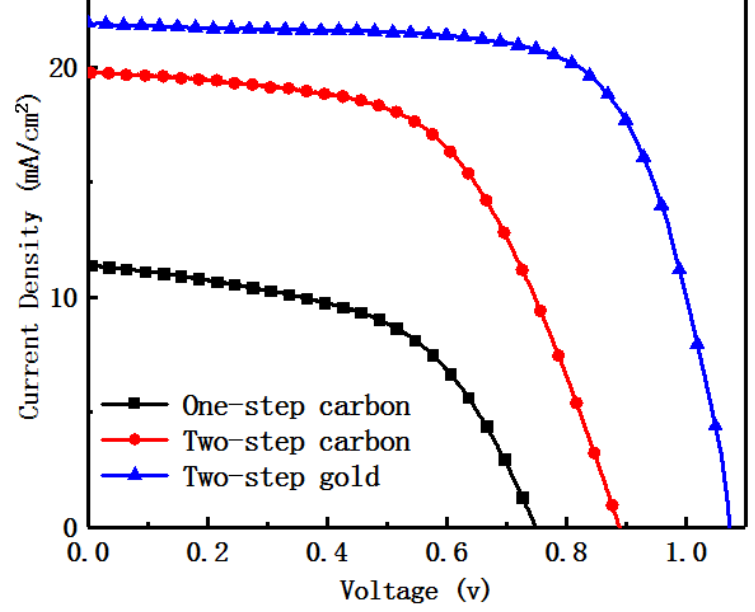
Figure 7. Photocurrent voltage density reverse scan (RS) curve of One-step carbon, Two-step carbon and Two-step gold.